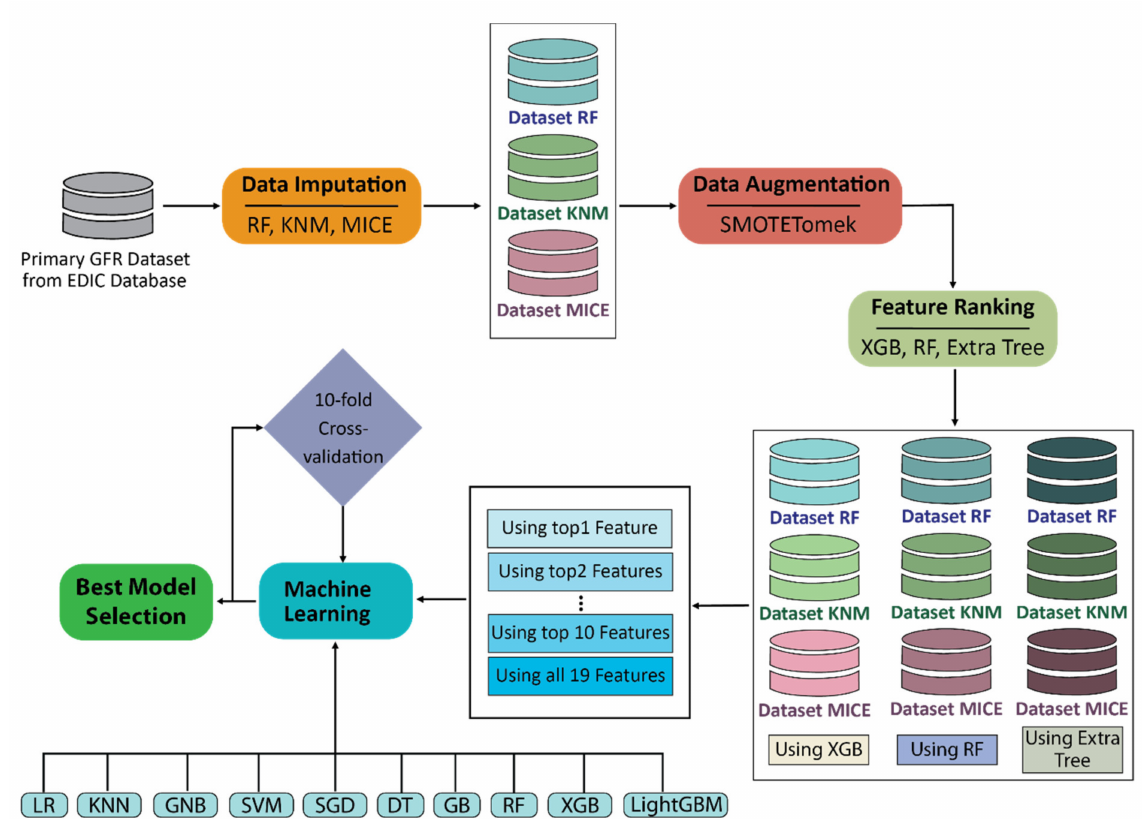
Figure 1. Block diagram of the overall working procedure for training and testing different machine learning models for CDK prediction in T1DM